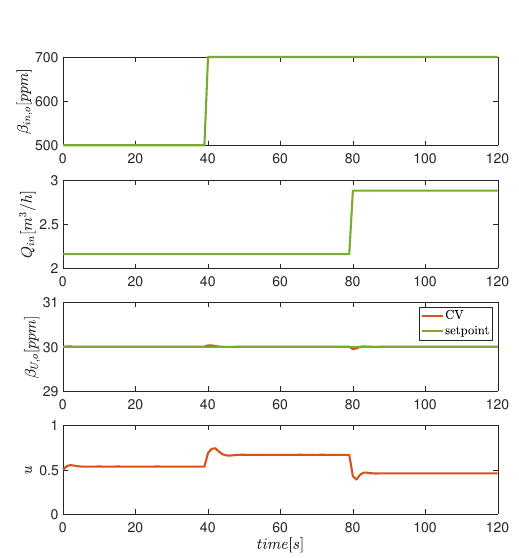
Figure 10: Simulation result of the MPC implementa- tion. The controller first tracks the under- flow oil fraction setpoint. Disturbances en- ter the system at 40 s and 80 s, represented by a change in the inlet oil concentration and the inflow rate respectively. The con- troller rejects both the disturbance main- taining β U,o at its